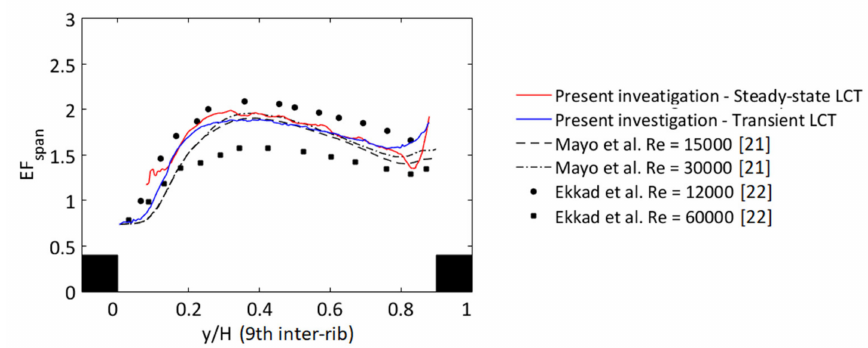
Figure 15. Span-wise averaged enhancement factor in static